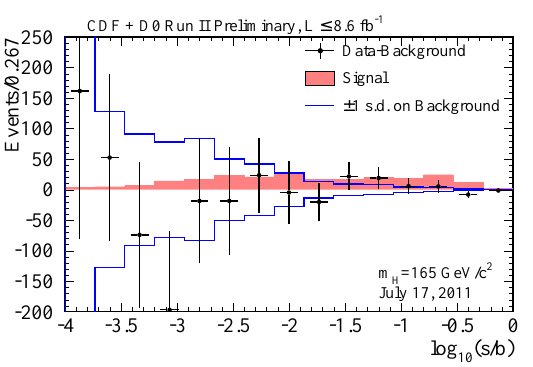
Fig. 3. Background-subtracted distributions of lo g 10 ( s / b ) for the data from all contributing channels from the combined CDF and D0 analyses for m H = 165 GeV / c 2